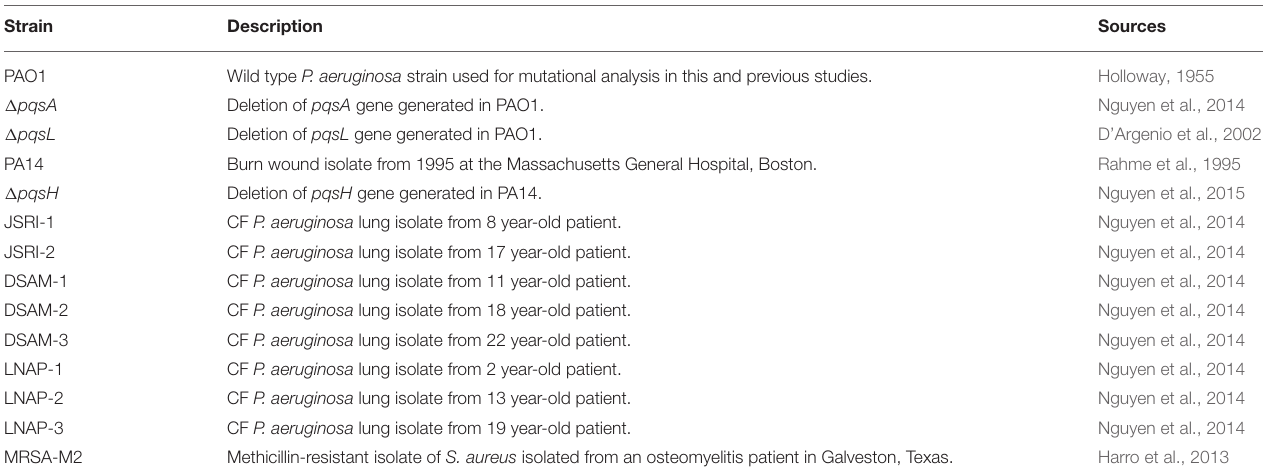
TABLE 1 | Strains used in this